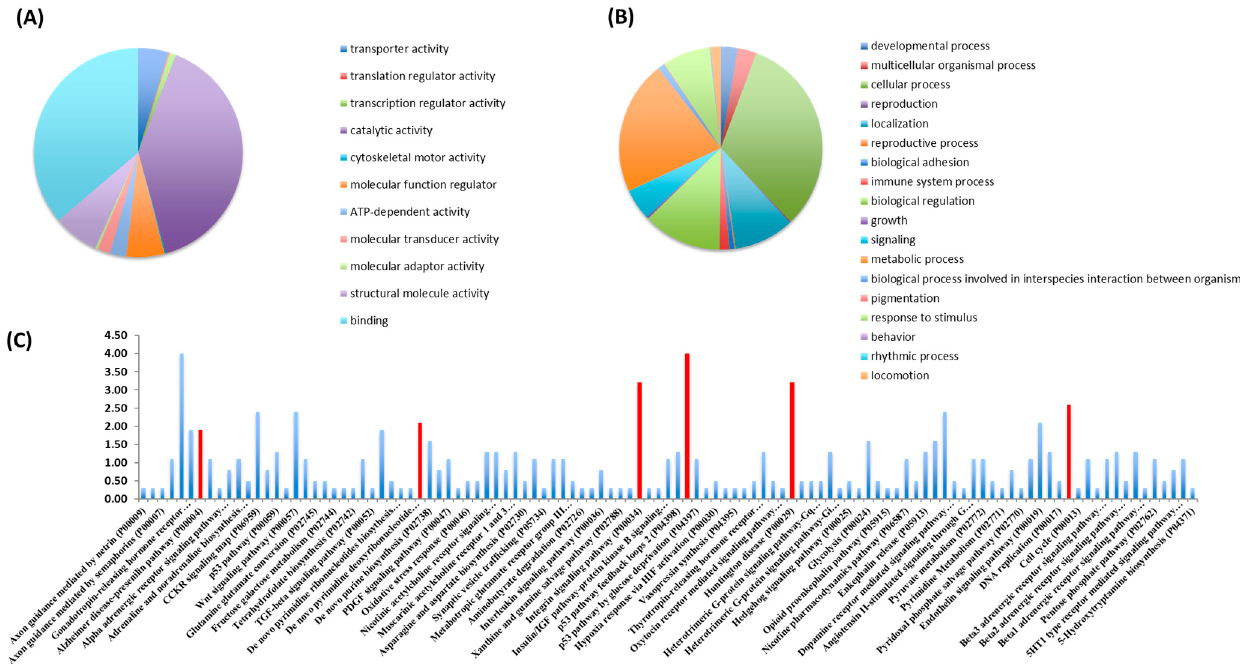
Figure 1. Classification of proteins identified in Nosustrophine based on their molecular functions